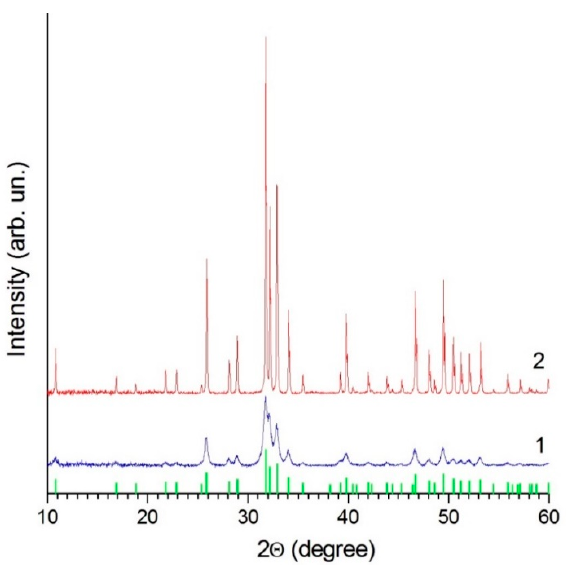
Figure 3. XRD patterns of nano-HA (1) and calc-HA (2) powders. The bar chart corresponds to PDF file 40-11-9308 (ICDD PDF-4) of crystalline HA.